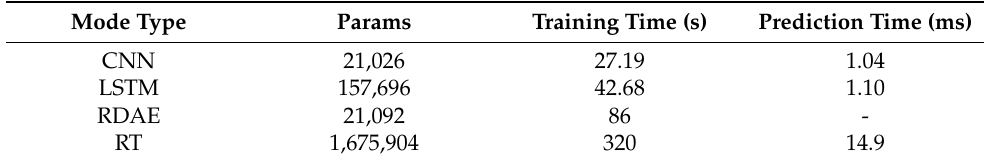
Table 3. The Algorithm Complexity of Different Models.